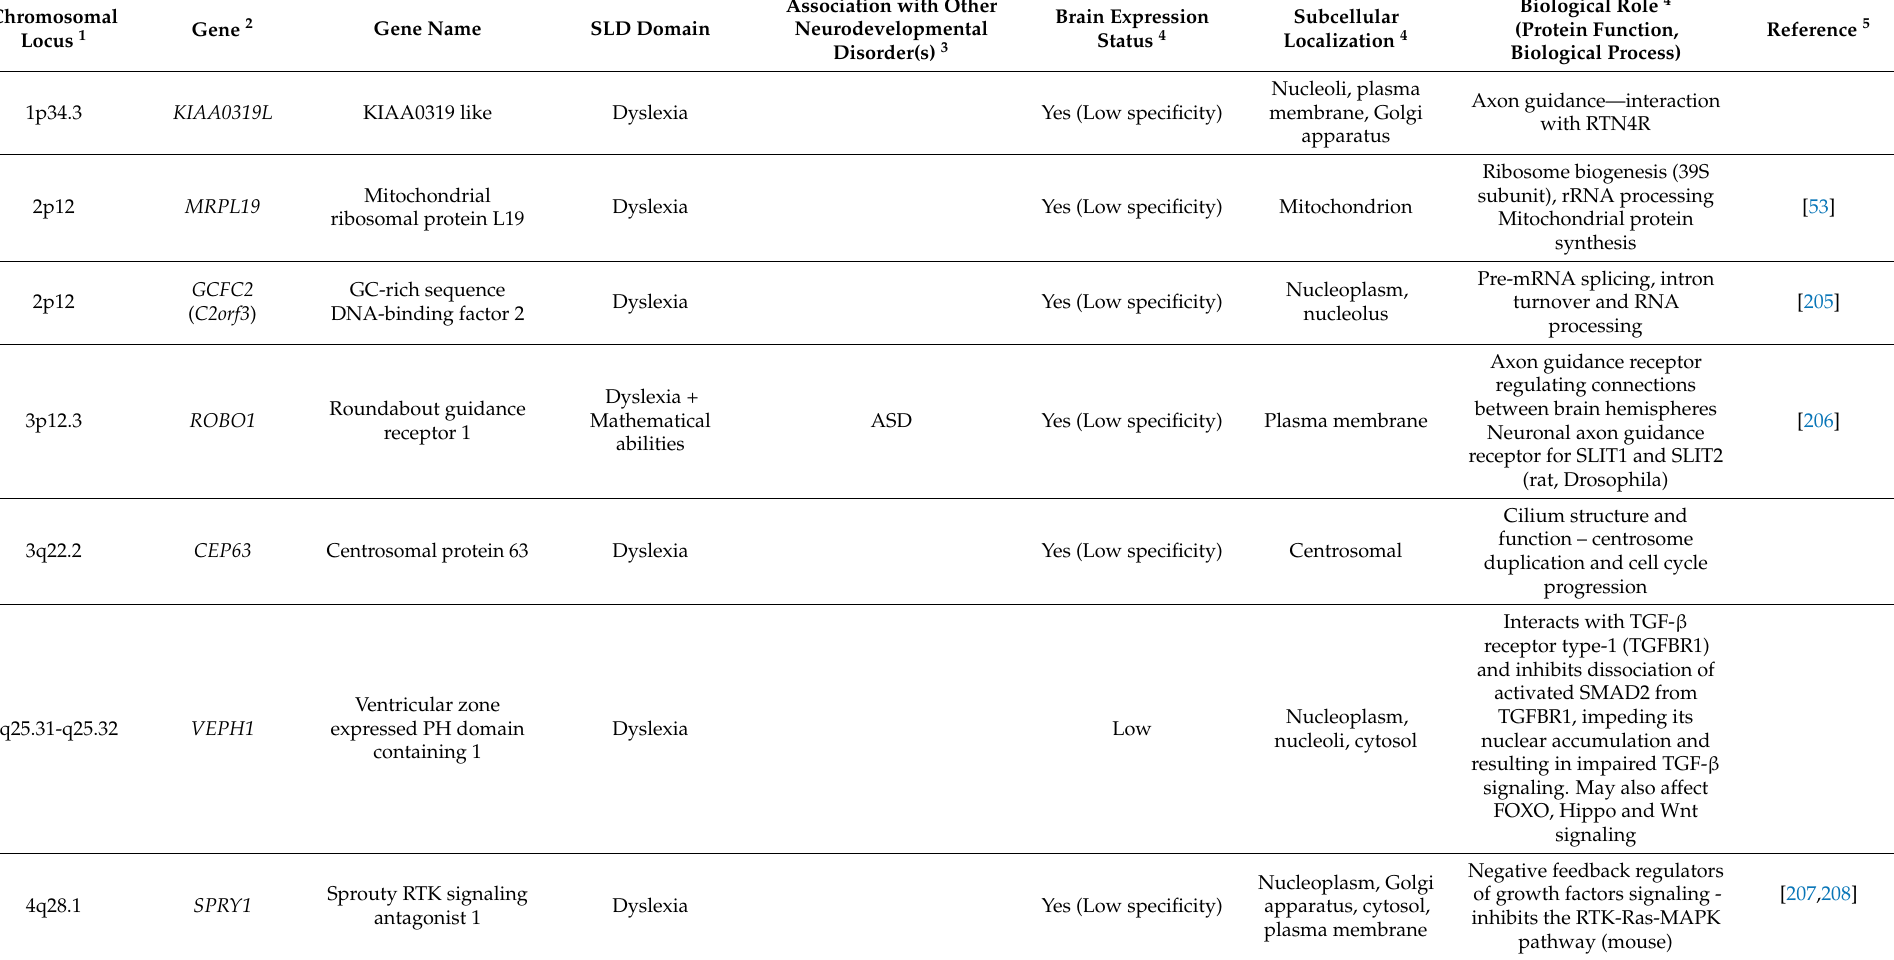
Table 5. Expression status in brain, cellular localization, and biological role of established and suspected genes associated with SLD susceptibility; the list is sorted by